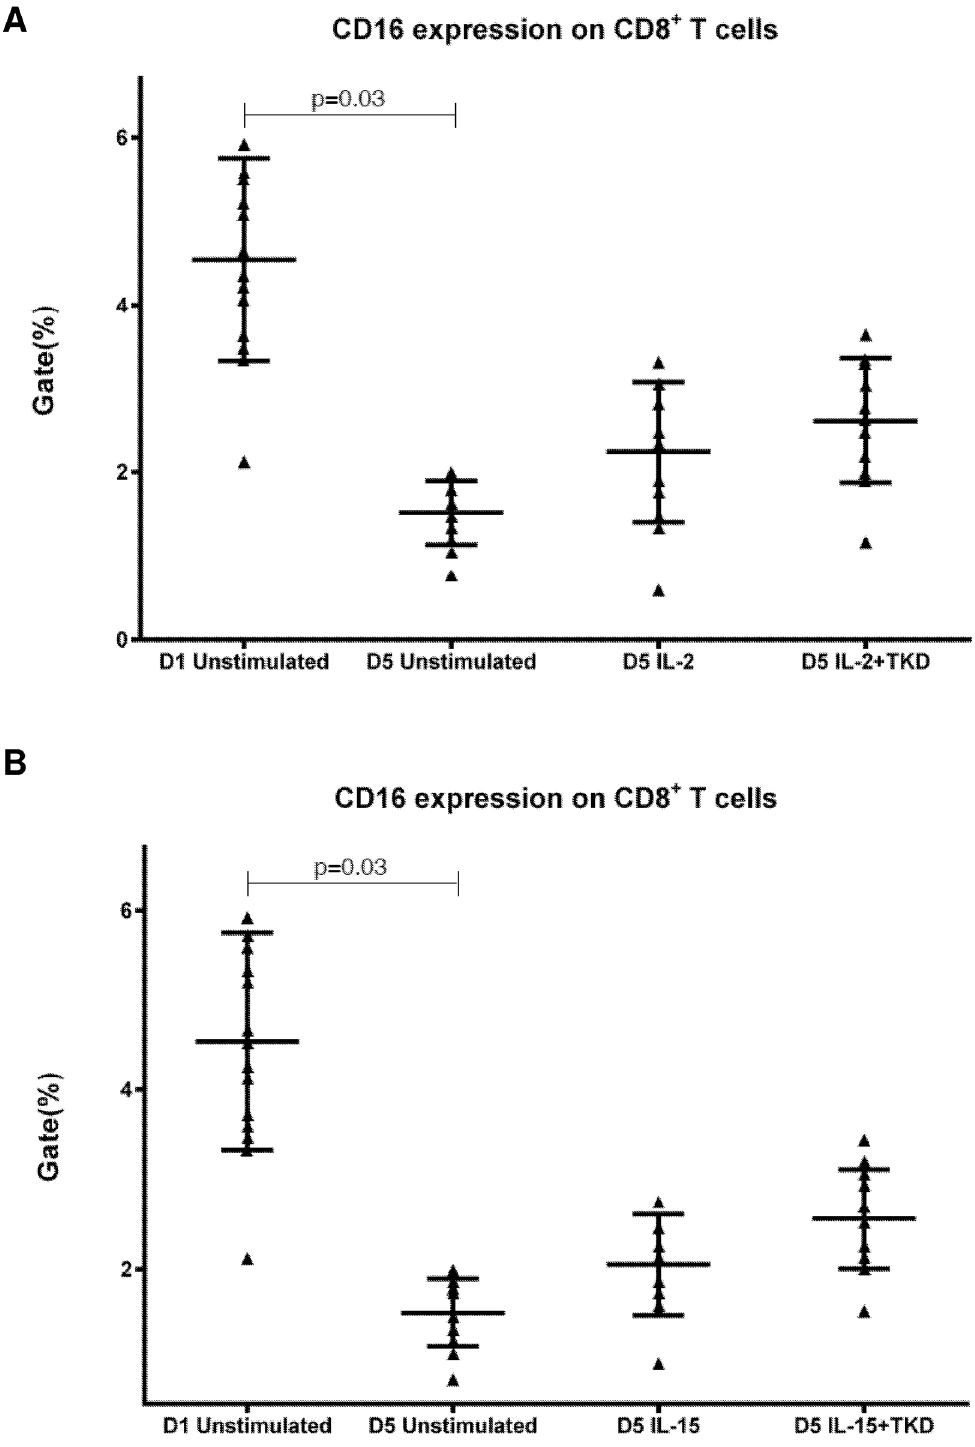
Fig 8. The effect of IL-2, IL-15, IL-2/TKD and IL-15/TKD on the expression of CD16 receptor in peripheral blood mononuclear cells of healthy individuals — the proportion of CD8 + T cells expressing an appropriate receptor. The expression of CD16 receptor on CD8 + T cells was examined within the fraction of unstimulated and stimulated mononuclear cells derived from 10 healthy individuals. Data are presented as means ± standard error. In total, the study cohort consisted of 52 Caucasian healthy individuals.